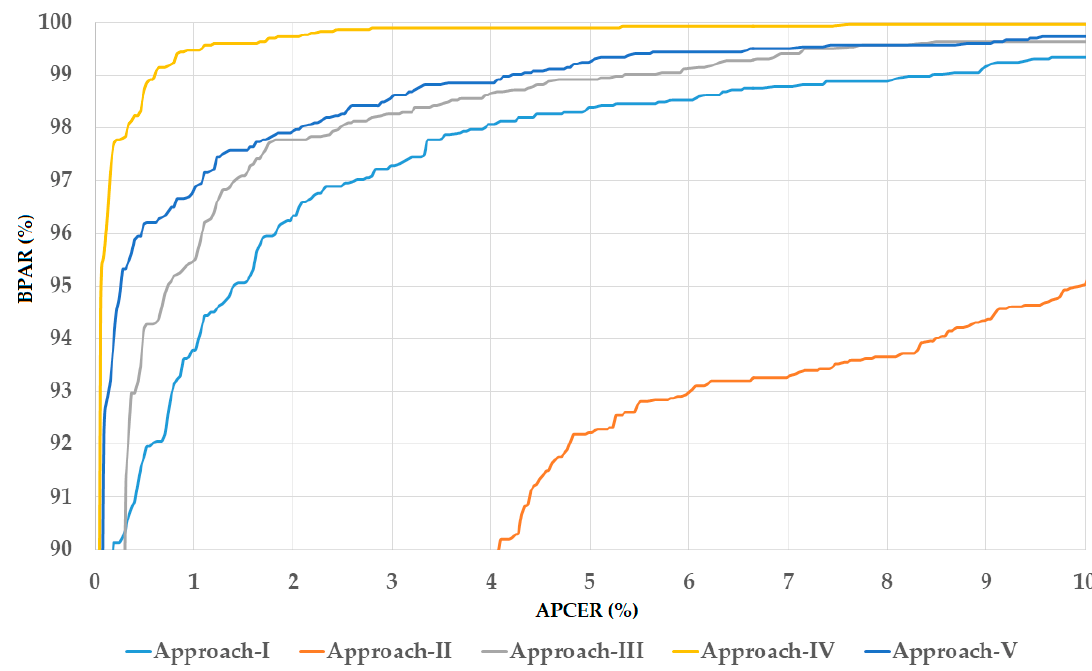
Figure 9. DET curves of iPAD systems according to best detection accuracy presented in Table 12b using three-channel images of fusion of gray and Retinex images for iPAD.